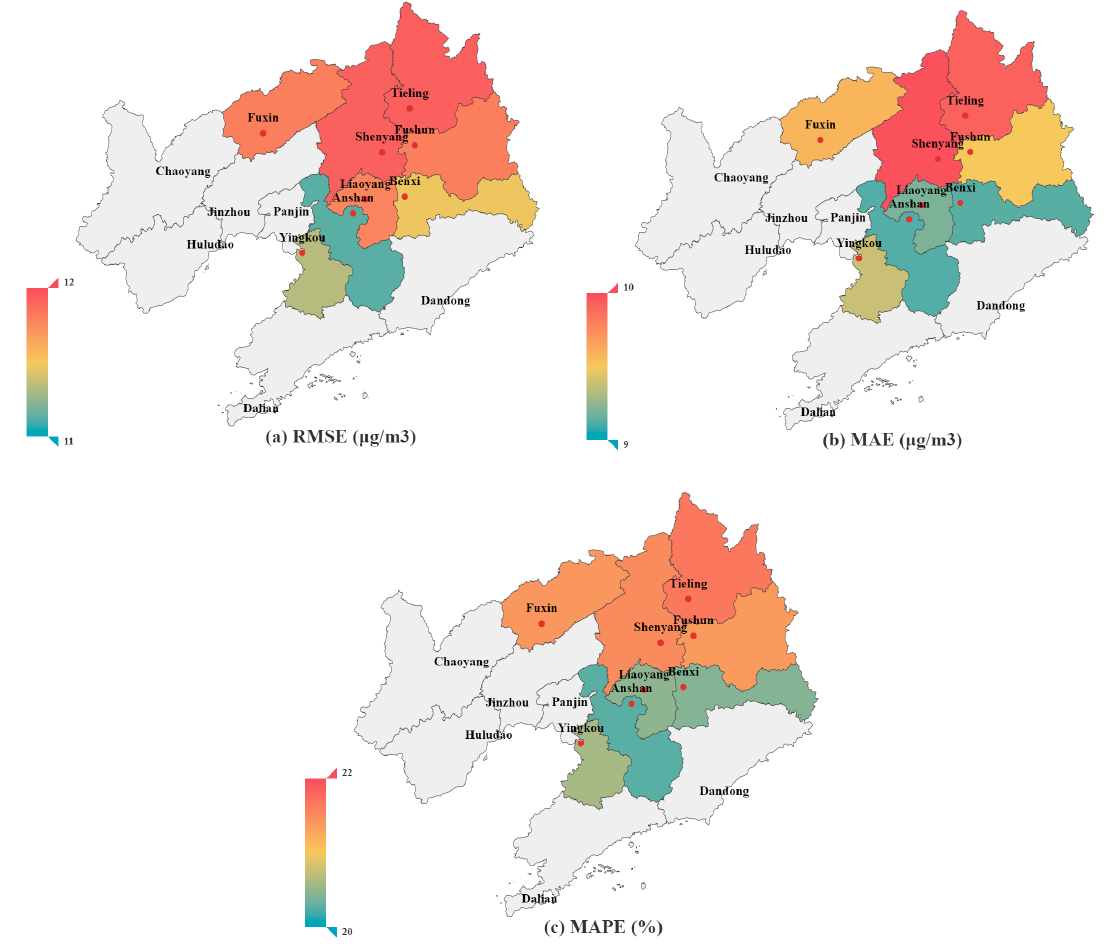
Figure 7. Performances of forecasting PM 2.5 in sub-regions.